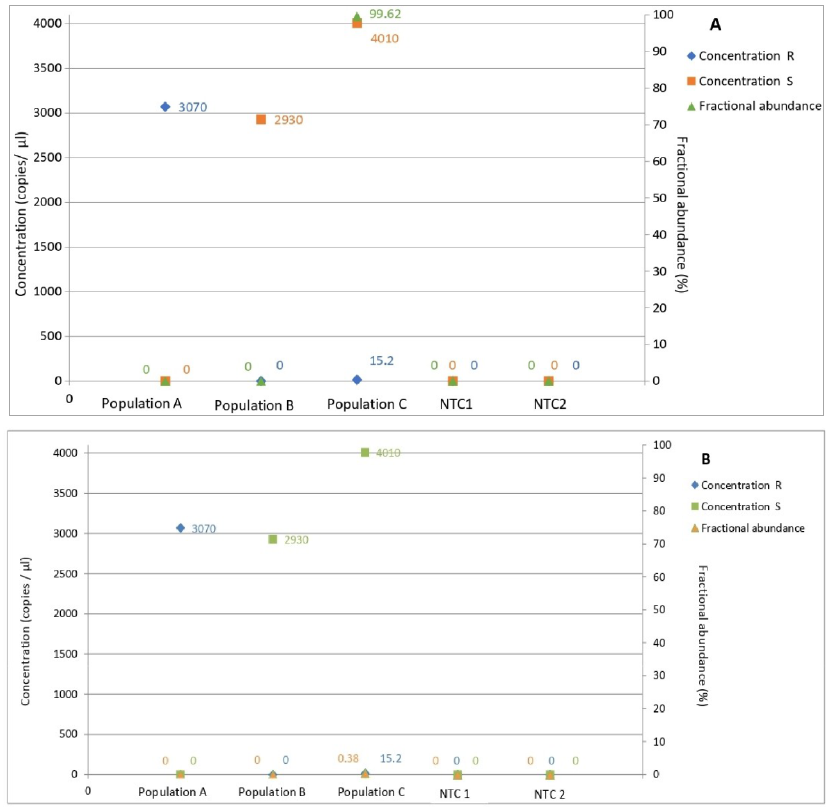
Figure 4. Linear correlation between values of measured copy number quantified by ddPCR ( y -axis) and the known copy number composition of samples obtained by the mixture of gDNAs from A.1 and B.1 monoconidial isolates ( x -axis). ( A ) Quantification of allele A143 in samples of group 1. ( B ) Quantification of allele G143 in DNA mixture of group 2.